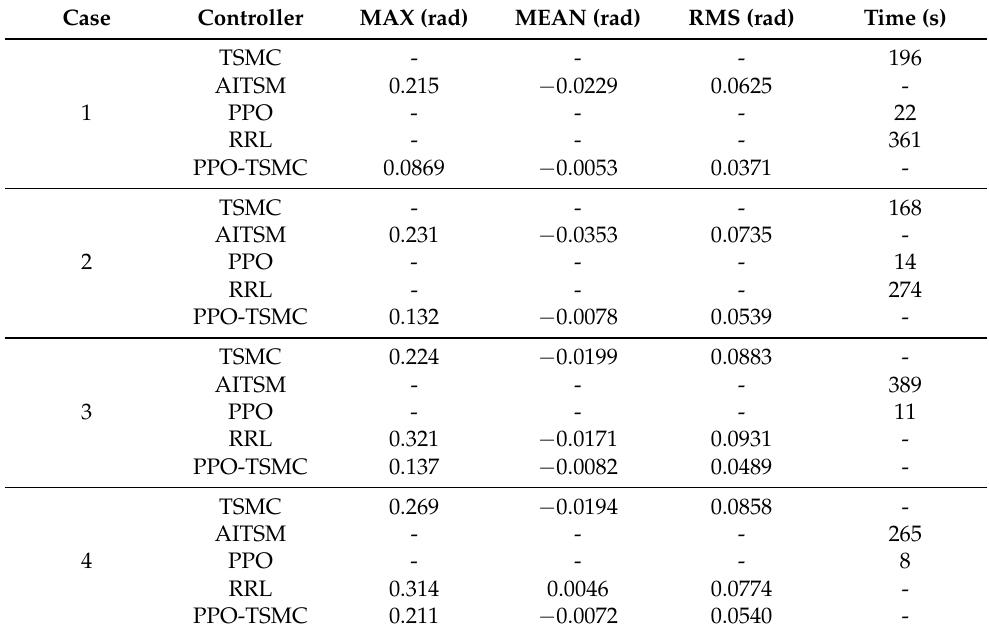
Table 2. Performance comparisons of five